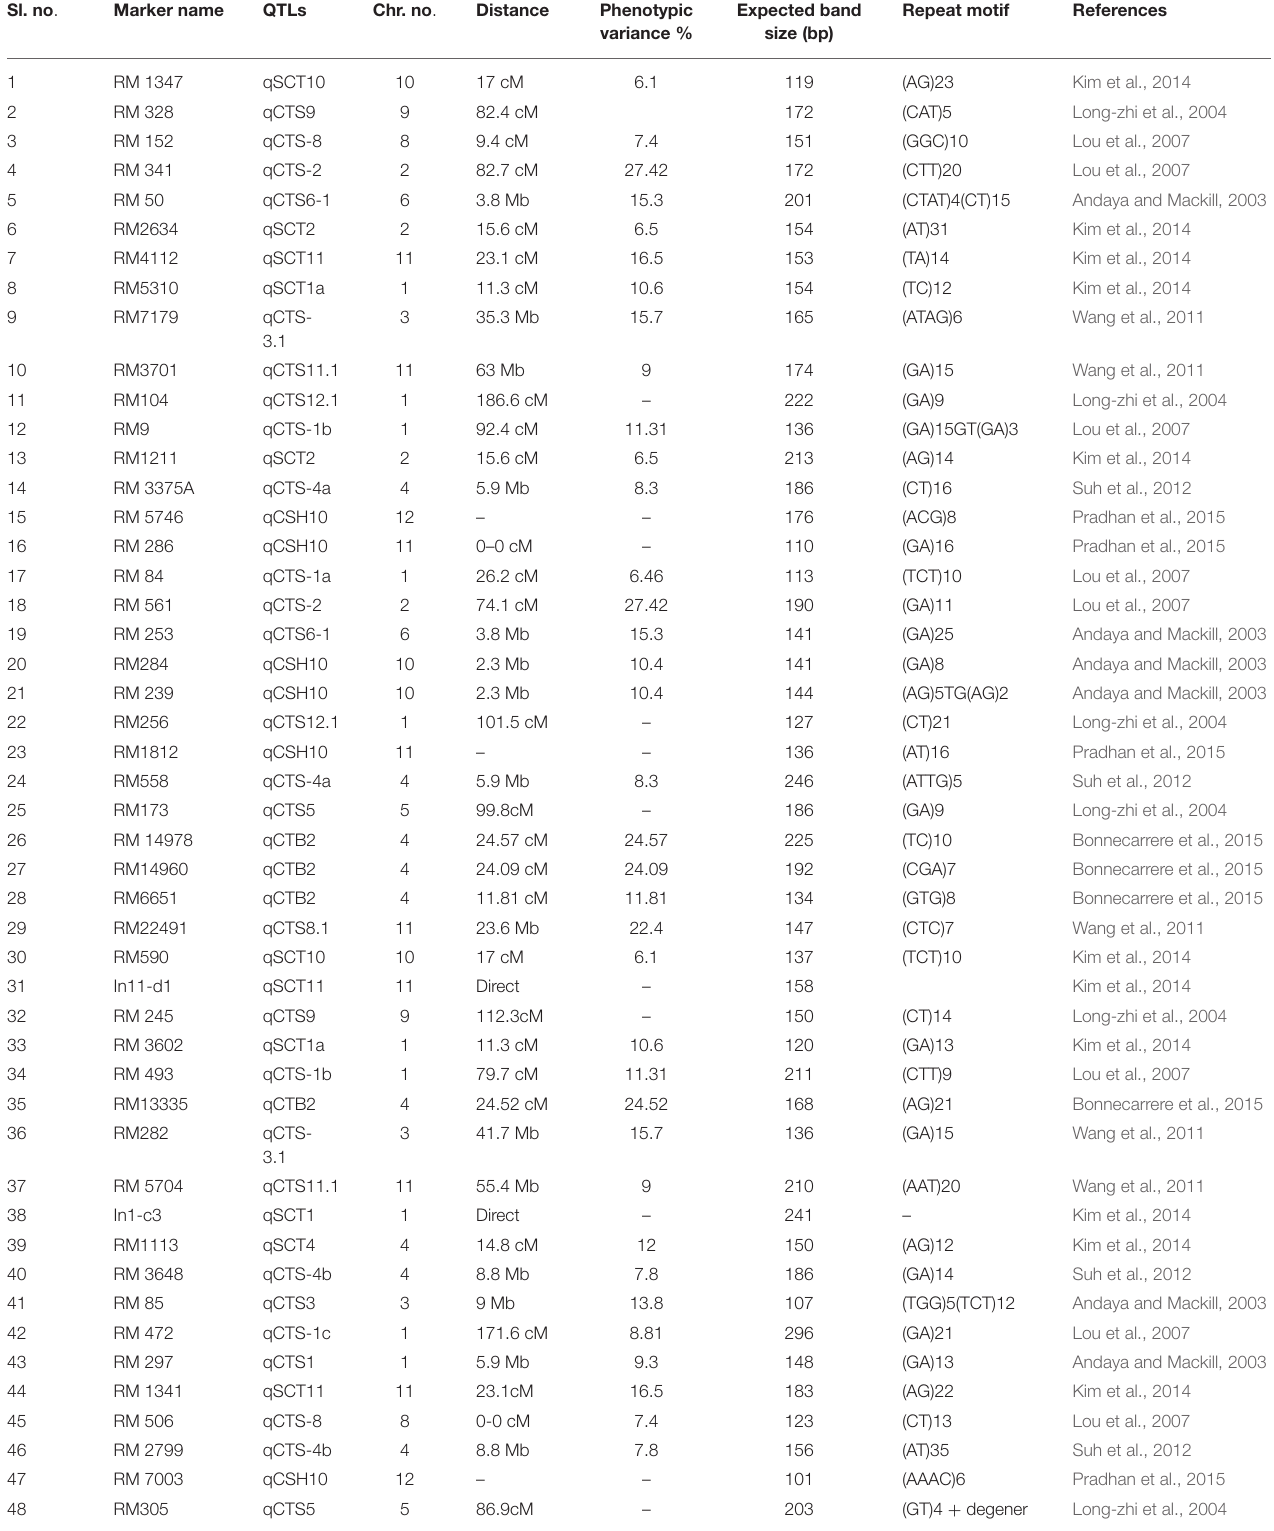
TABLE 2 | Information on the selected 60 linked molecular markers used for seedling stage chilling stress tolerance in indica rice. Sl. no